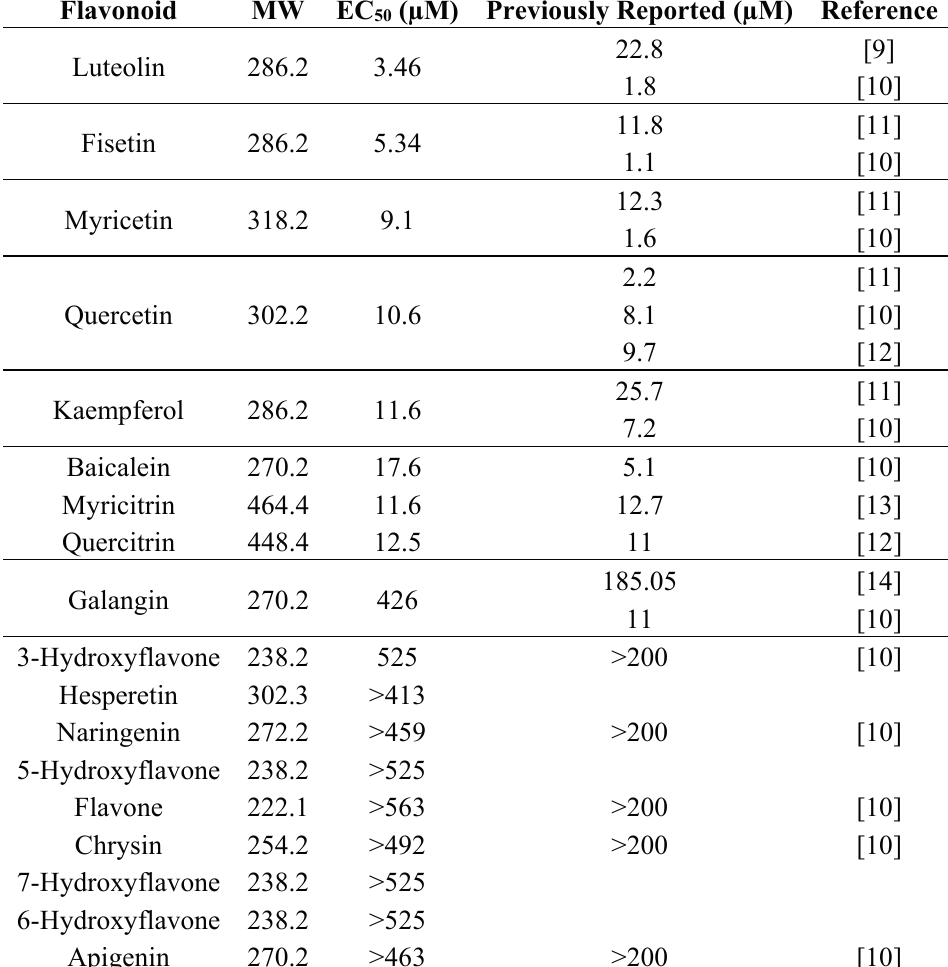
Table 2. EC 50 for reduction of 2,2-diphenyl,1-picrylhydrazyl